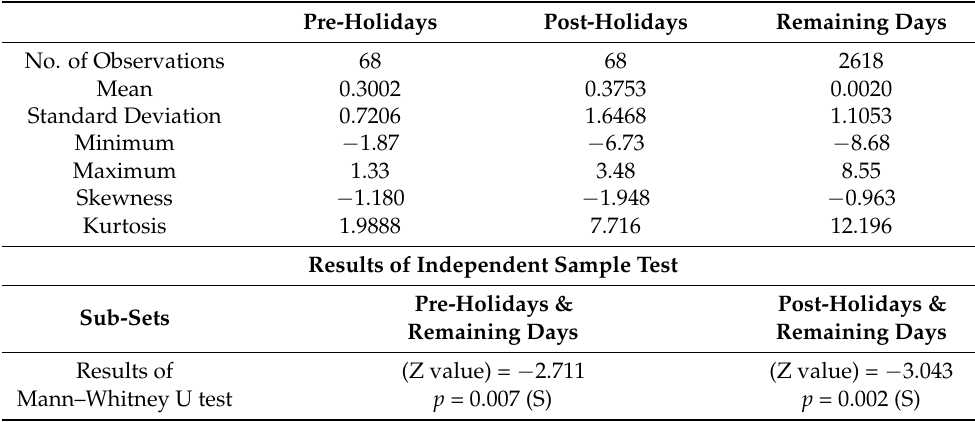
Table 9. The Results of Descriptive Statistics for TASI Daily Returns for Pre, Post-Holiday